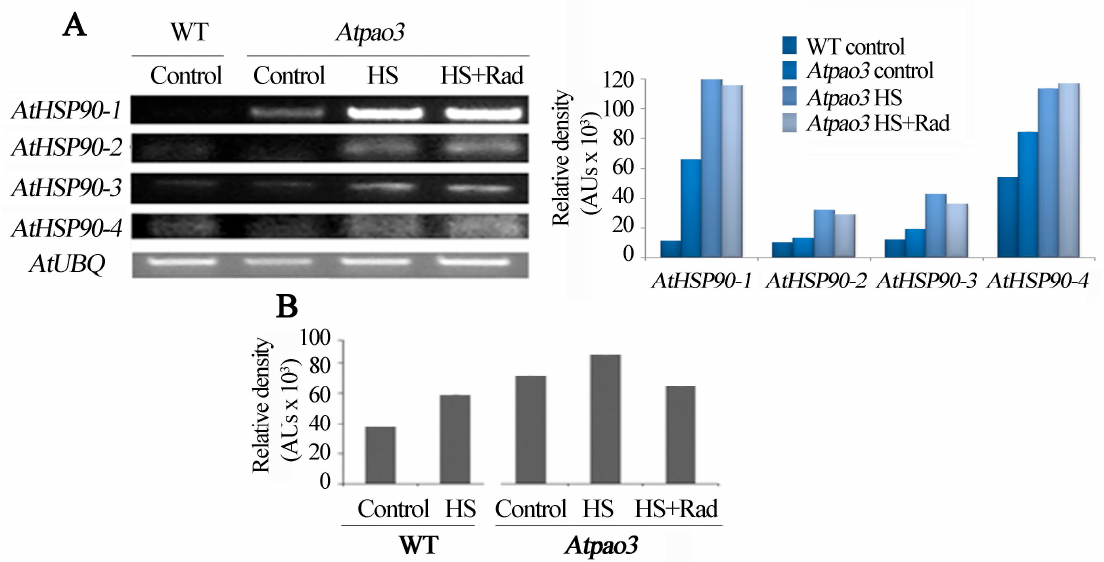
Figure 6. Abundance of cytosolic AtHSP90 mRNA in WT and Atpao3 mutant and HSP90 protein levels. Leaves were treated with HS and HS + Rad for 1 h at 42 ◦ C. ( A ) Reverse transcriptase (RT)-PCR of the four AtHSP90 cytosolic genes ( AtHSP90 1–4 ) and relative intensities of bands normalized against ubiquitin. ( B ) Quantification of the HSP90 immunoreactive protein in control and HS- treated WT leaves, as well as in controls, HS and HS + Rad treated Atpao3 leaves.